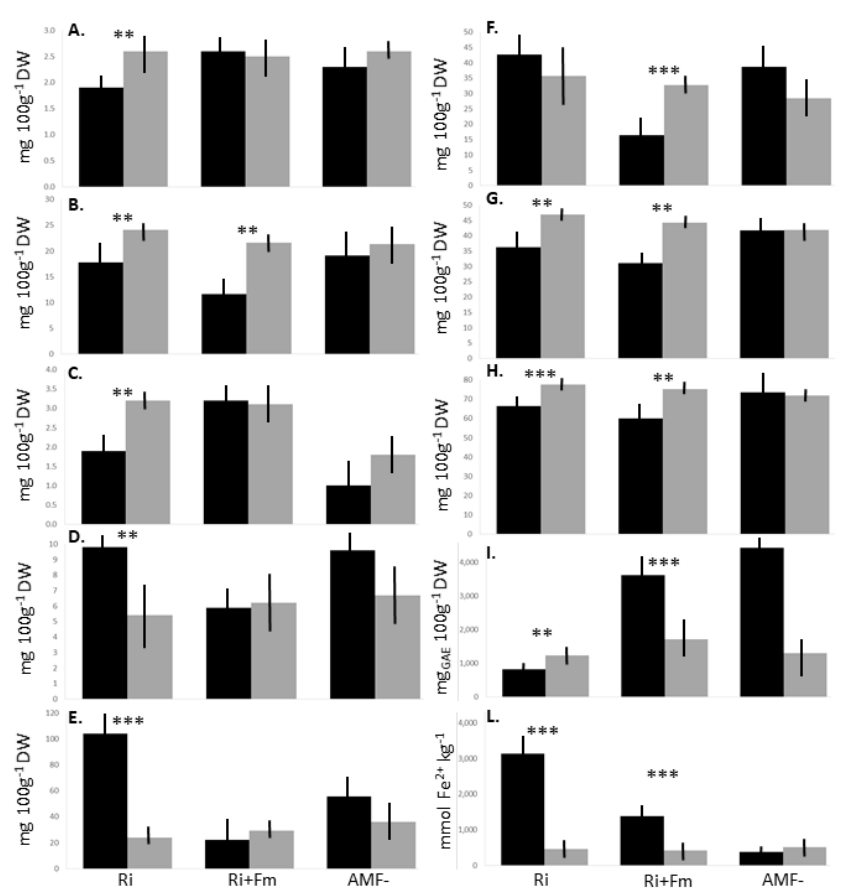
Figure 5. Effects of AMF inoculum consisting of Rhizophagus intraradices alone (Ri), R. intraradices and Funneliformis mosseae (Ri + Fm) or a control (AMF-) on the content of (A.) isoquercitrin, (B.) quercitrin, (C.) ellagic acid, (D.) epicatechin, (E.) crocin I, (F.) crocin II, (G.) ascorbic acid, (H.) vitamin C, (I.) total polyphenol content (TPC), and (L.) antioxidant activity (FRAP assay) of saffron produced in soilless (black bars) and open field (grey bars, [12]) conditions. Mean comparisons of each treatment in the two cultivation types were performed using an independent samples t‐test.